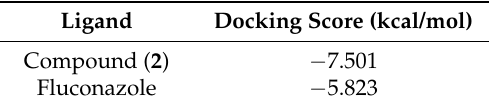
Figure 2. ( a ) 2D and ( b ) 3D docking pose of the compound ( 2 ) with MTCYP51. Table 1. Docking score of the compound ( 2 ) and the bound ligand fluconazole.